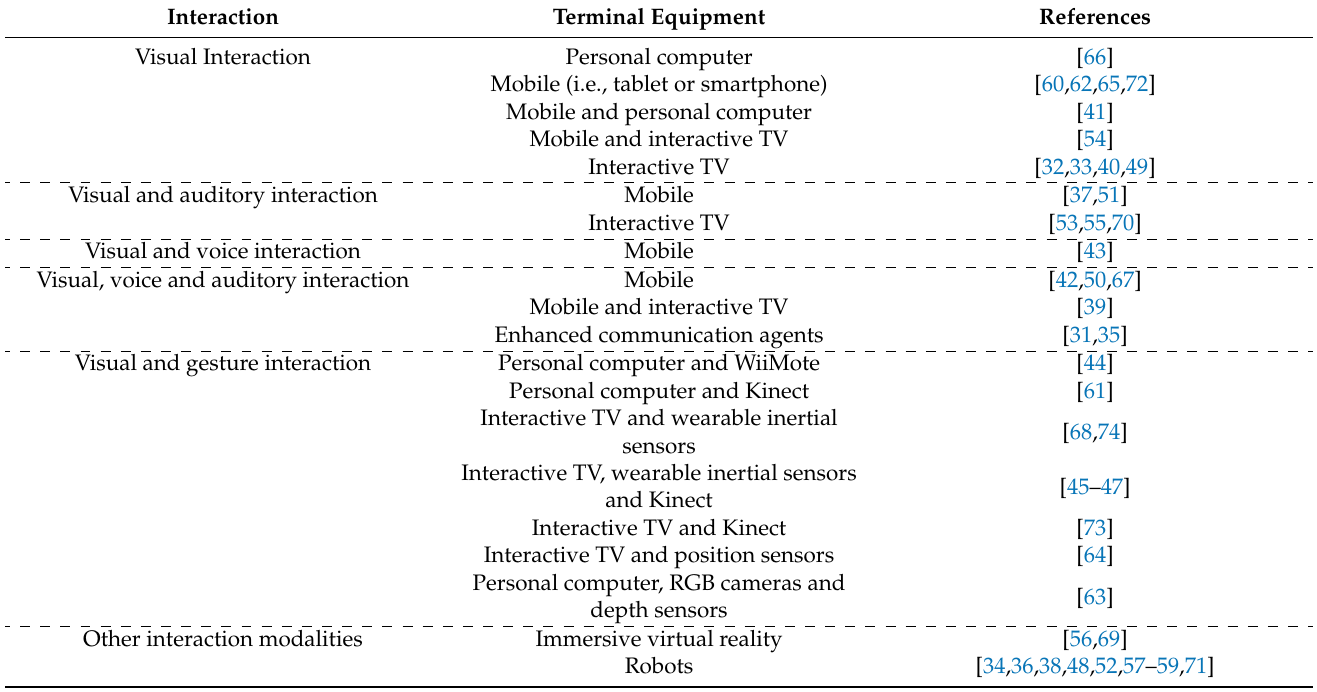
Table 3. Interaction modalities and respective terminal